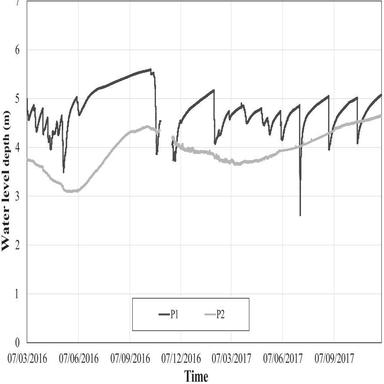
Depth evolution of the water table with respect to the current ground level in piezometers P1 and P2 (see.